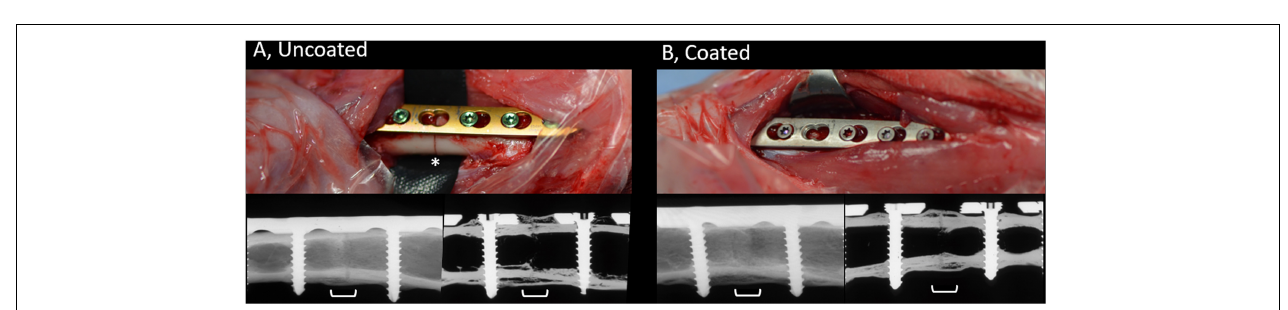
FIGURE 3 | Appearance of uncoated (A) and 2-AI-based coated (B) plates during placement and radiographic appearance of healing at time of study completion. Upper row, intra-operative pictures of the surgical site prior to wound closure showing LCPs being fixed to the bone. Skeletally mature rabbits received a 7-hole LCP and six screws. Note the position of the osteotomy beneath the empty screw hole on left hand side image (asterisk). The uncoated plates and screws are as purchased with coloring due to anodization. The color of the coated plates and screws match, due to the coating process that was applied. Lower row, post-mortem contact radiographs of the bone (left) or after sectioning (right), centered on the osteotomy (white bracket). Note the complete bridging of the osteotomy gap and the formation of periosteal callus at the osteotomy site. The osteotomy is still visible indicative of ongoing healing. Images were randomly selected as representative of the entire